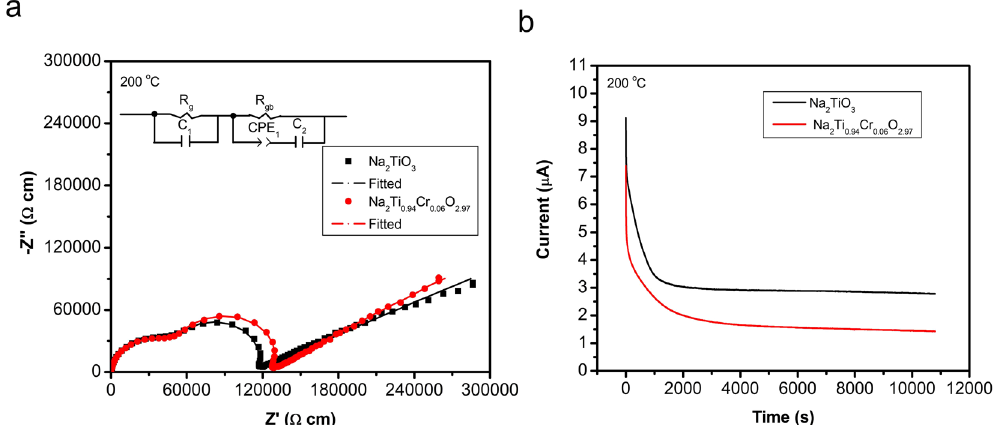
Figure 3. Conductivities of Na 2 TiO 3 and Na 2 Ti 0.94 Cr 0.06 O 2.97 measured in air at 200 °C. ( a) AC impedance plots • ◾ : Experimental values. The solid line represents simulated data using an equivalent circuit of (R g C 1 ) (R gb CPE 1 C 2 ) (where R g and R gb are the resistances of grain and grain-boundary respectively, CPE is the constant phase element, C is the capacitor). ( b) DC polarization measurement at constant voltage of 1 V using Ag blocking